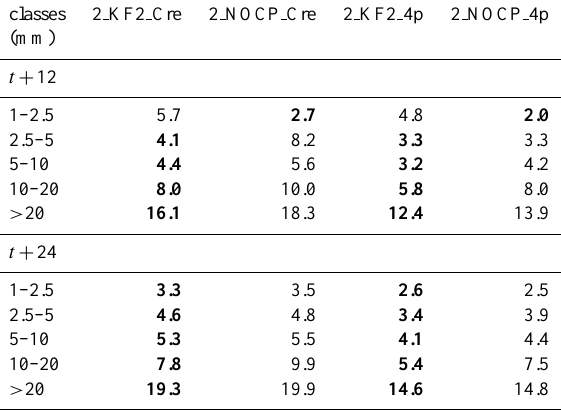
Table 3. Mean Absolute Error (MAE) (mm) for forecast with Kain- Fritsch-2 (KF2) and without activation of the CPS (NOCP) in the 2km grid with Cressman and 4 points method. The best values for each method are presented in